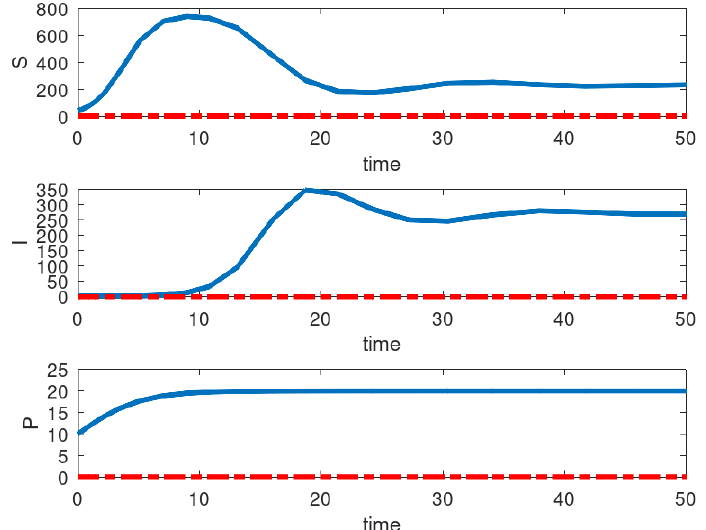
Figure 3. Coexistence E ∗ can be attained with the parameters in (23) and initial conditions (22). The red dashed line indicates the zero